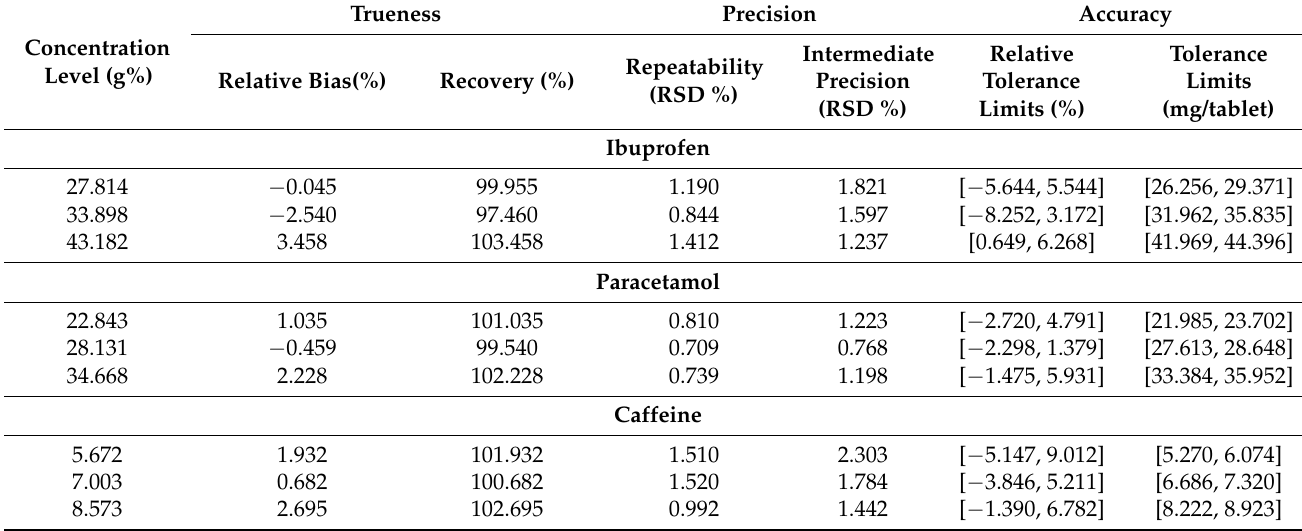
Table 2. Validation results for the NIR method developed for at-line